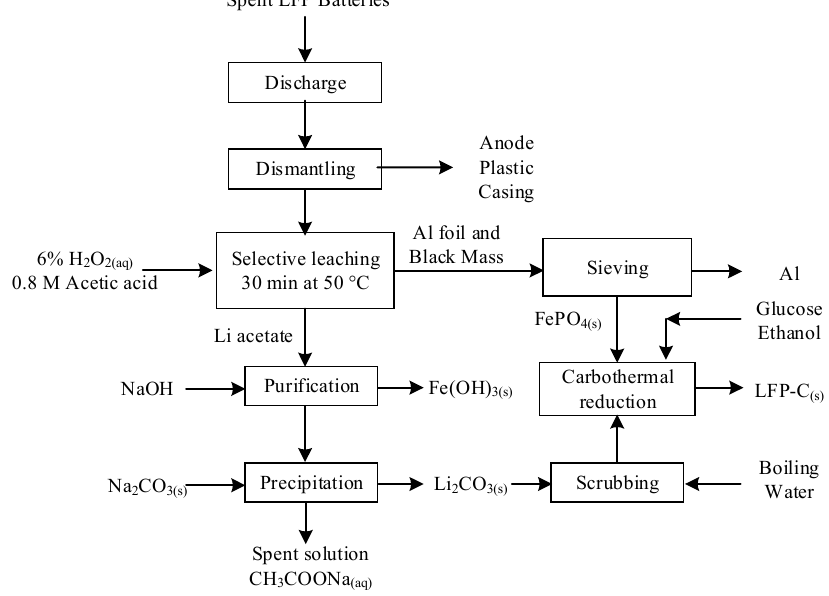
Figure 15. Selective leaching of LFP proposed by Yang et al. (according to [77]).